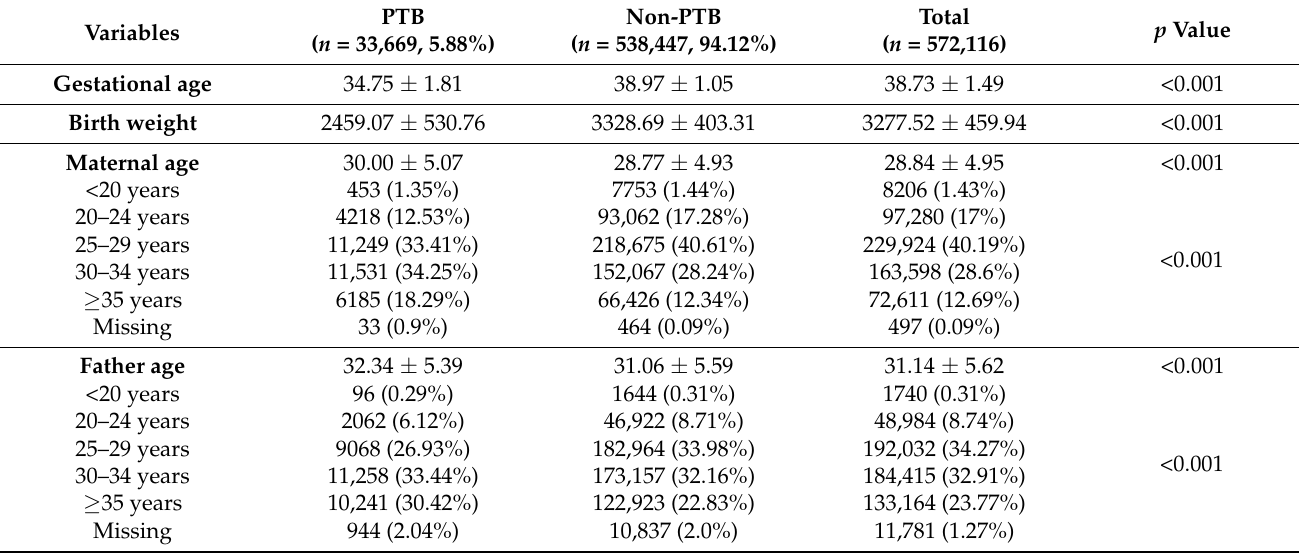
Table 1. The descriptive summary of the general characteristics of live birth